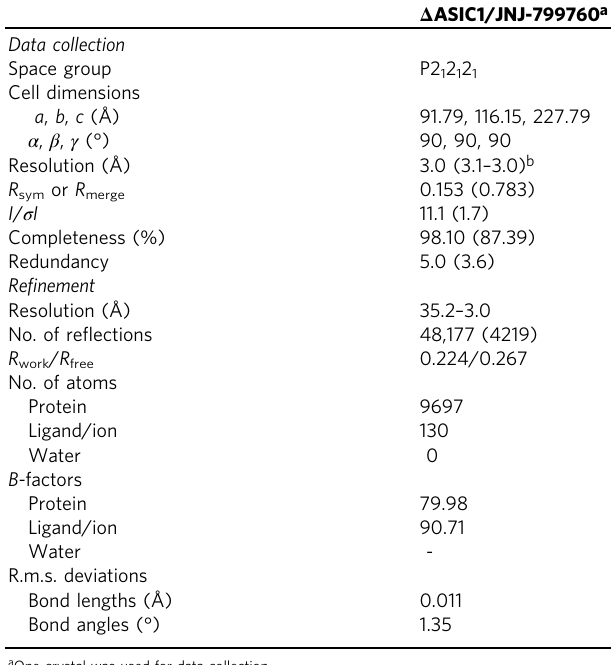
Table 1 Crystallographic data collection and re fi nement